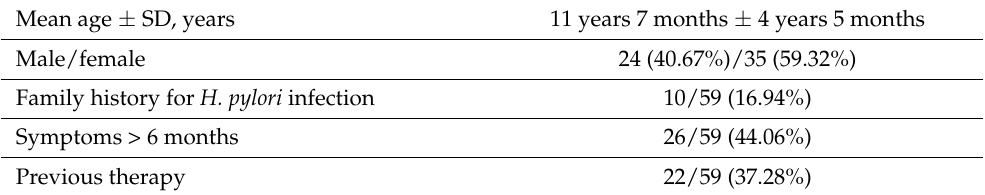
Table 1. Demographic and clinical characteristics of the patients.